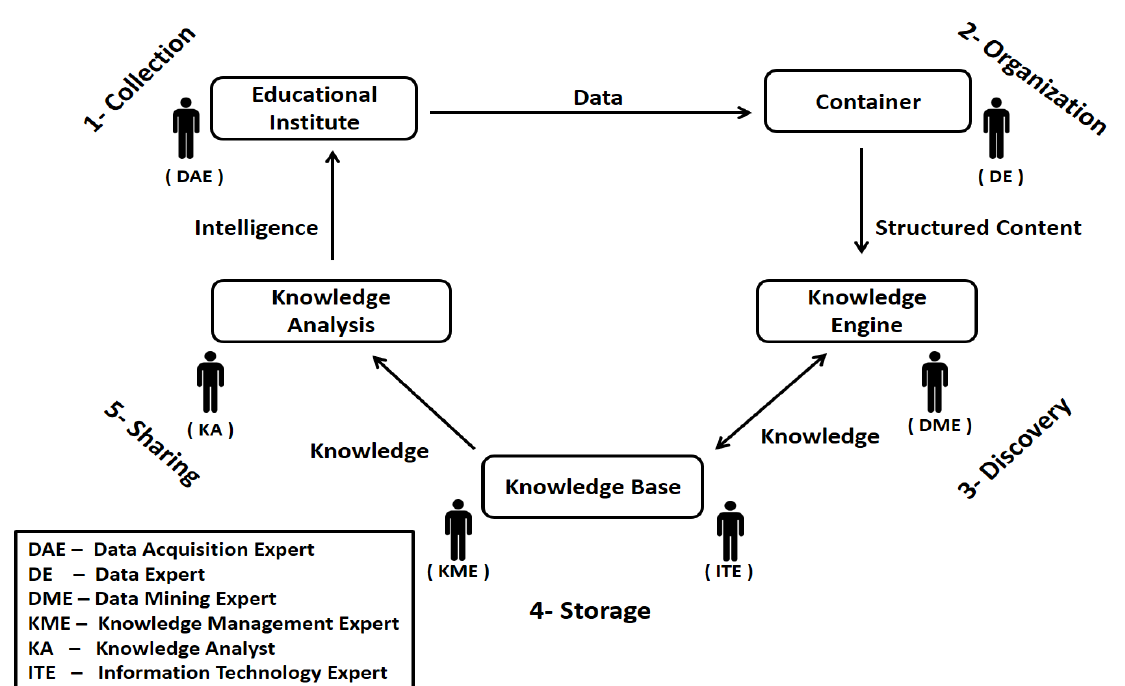
Fig. 1: A Framework for Knowledge Management in Education